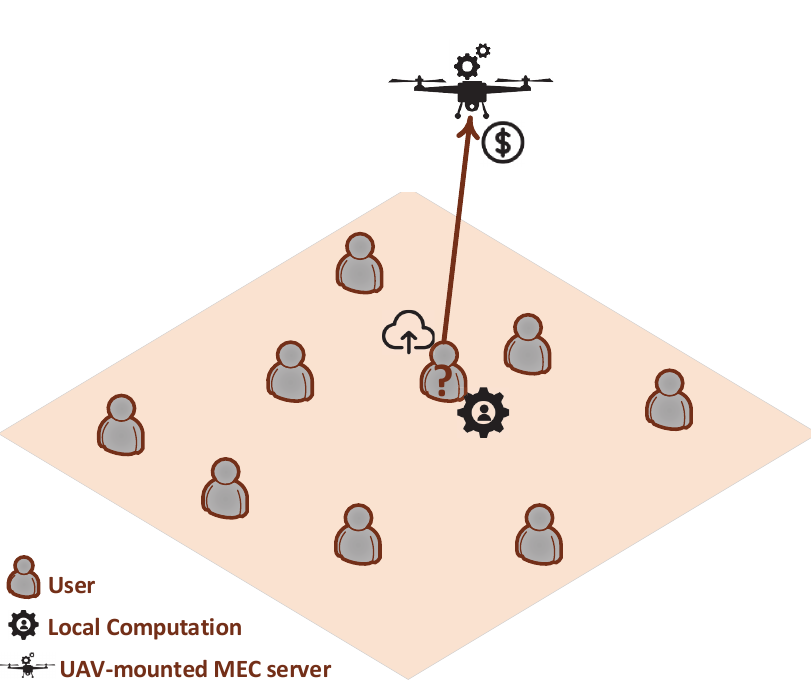
Figure 1. UAV-assisted multi-access edge computing